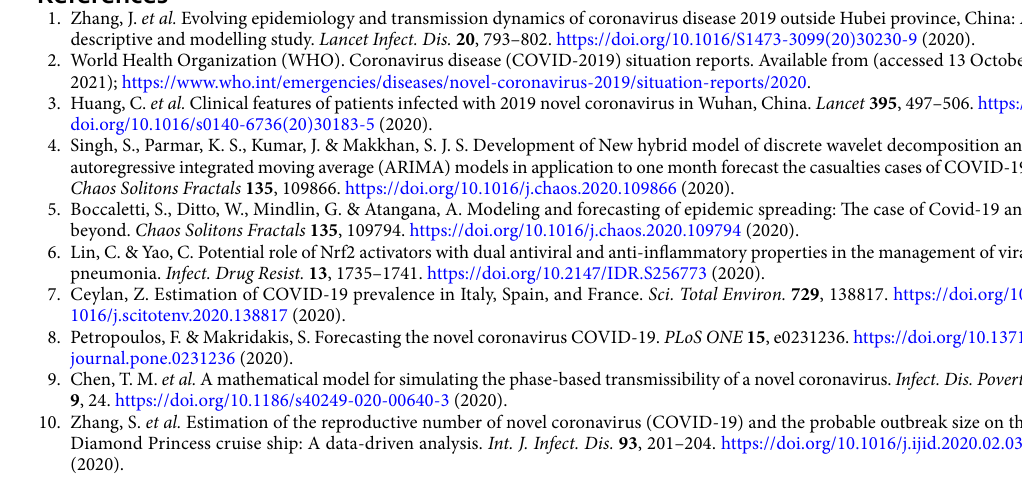
Diamond Princess cruise ship: A data-driven analysis. Int. J. Infect. Dis. 93 , 201–204. https:// doi. org/ 10. 1016/j. ijid. 2020. 02. 033 (2020).